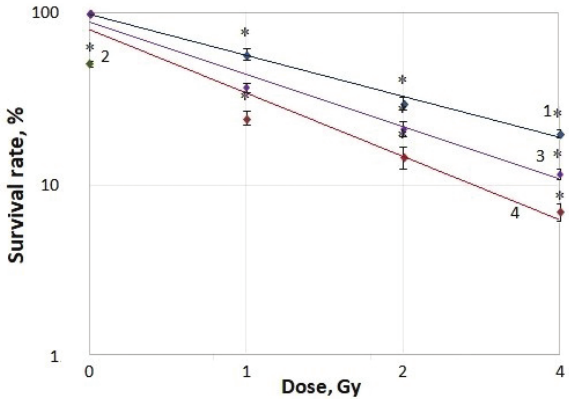
radiation dose (* – reliable difference with the statistical signifi - cance level at р < 0.05; curve errors – standard error of the